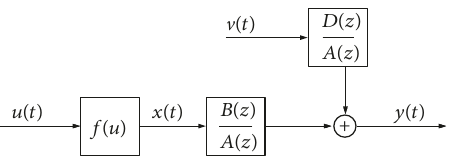
Figure 1: A system described by the Hammerstein CARMA